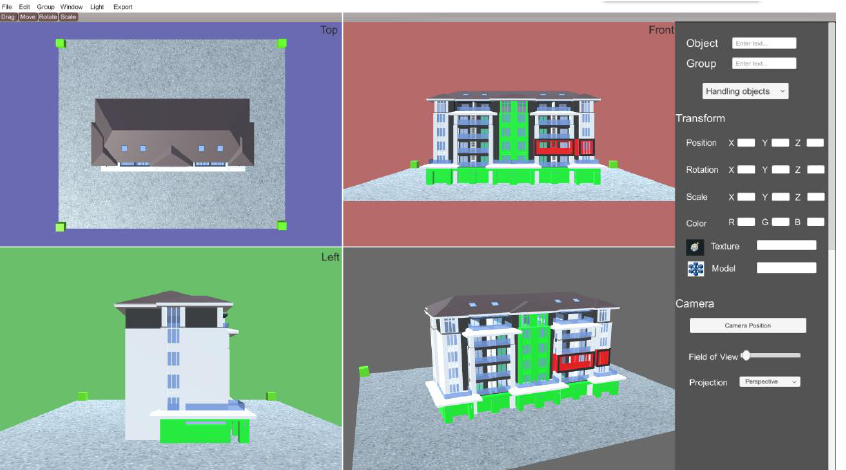
Figure 5. The snapshot of the symbol design application. The left part is a demonstrative 3D scene, and the right part is the interface where cartographers can set rules. Once the rule setting changes, the demonstrative scene will change on-the-air to give cartographers direct feedback.